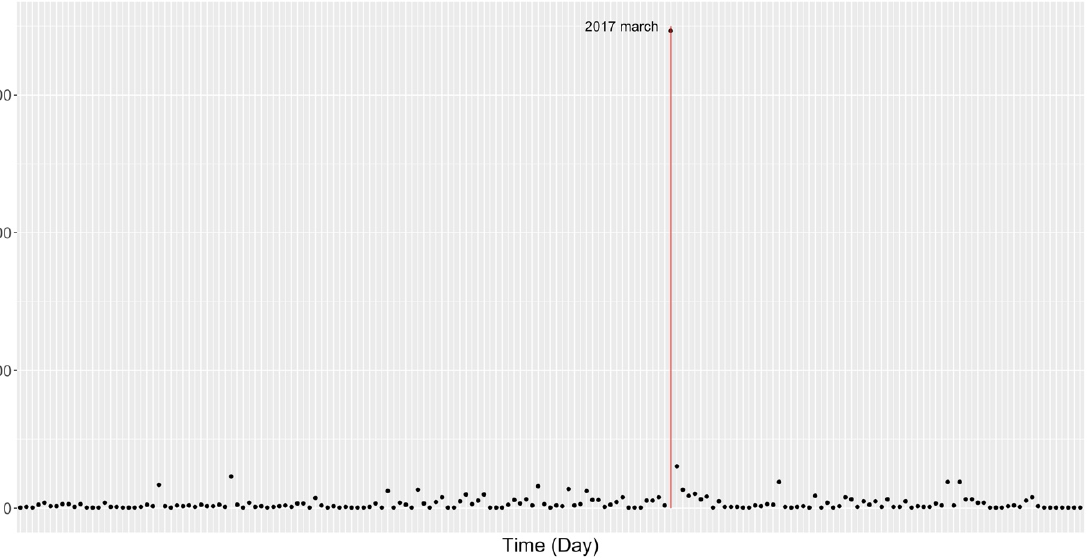
Figure 3. Number of comments made by old and new users in the two weeks before and after the 2017 march. 5. Discussion Examination of TBC’s online and offline activism has conveyed how Australian far- right extremist groups can connect and coordinate their online messaging with their of- fline activities. Based on these findings, we highlight how the online activities, in seeking to mobilise participation in offline events, raised expectations of a widespread social movement that were ultimately frustrated. By the time that the 2018 TBC March com- menced, the attendance had dropped to around 70 people, and the broader far-right movement appeared to go through a reorganisation phase, with more emphasis placed on realigning within a more extreme social context, adopting more extreme and openly neo-Nazi ideology, and new action-orientated activities to advance the extreme-right cause.